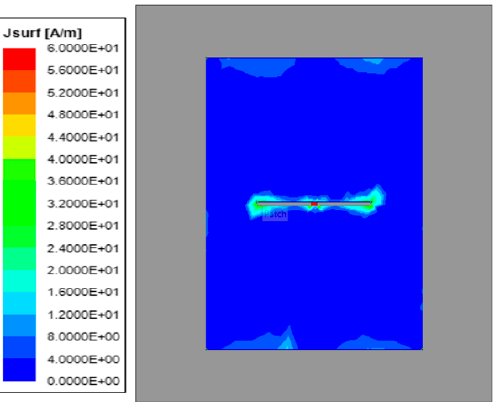
Figure 2. Simulated surface current density on the antenna’s radiating patch at 2.4 GHz.